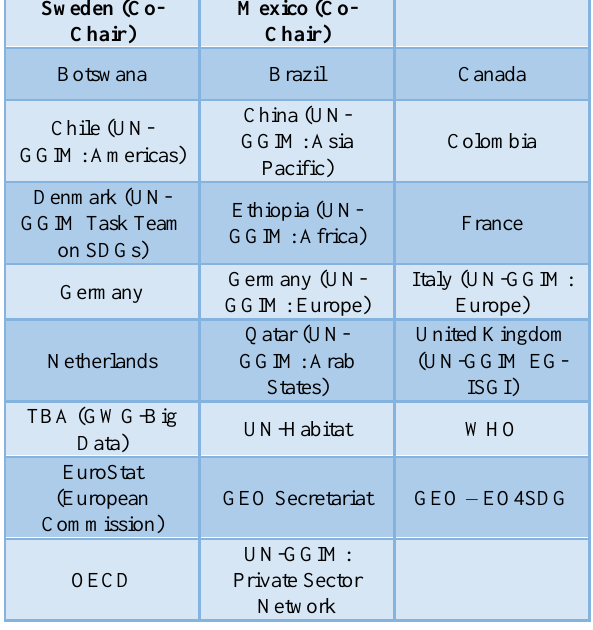
Table 1. Membership of IAEG-SDGS: WGGI (IAEG-SDGs: